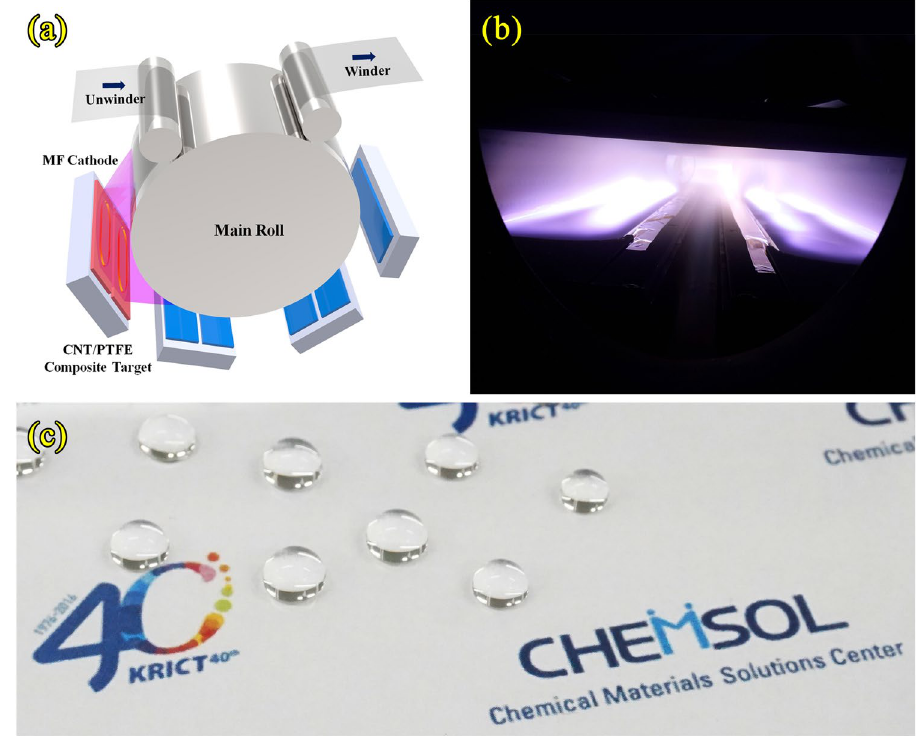
Figure 8. Images of ( a ) an enlarged schematic of the sputter chamber, ( b ) the sputtering plasma, and ( c ) the hydrophobic and transparent fluorocarbon thin film. CHEMSOL logo in the Fig. 8(c) was used under permission of the Chemical Materials Solutions